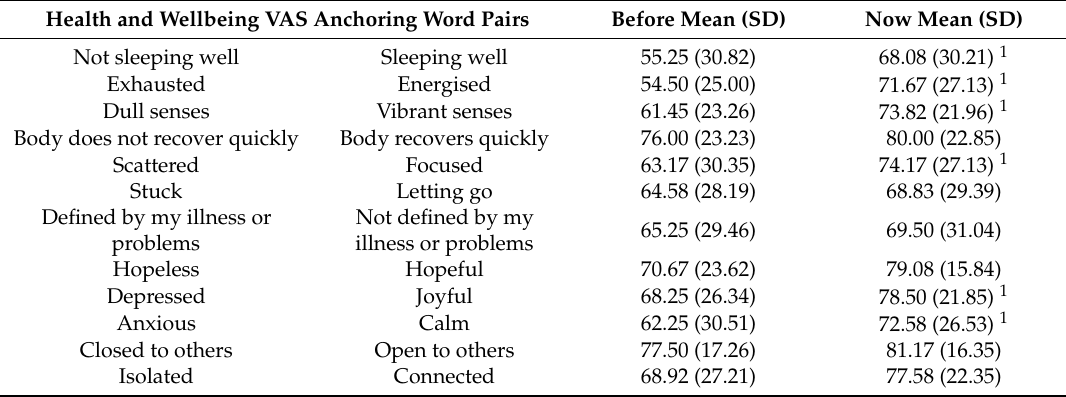
Table 1. Mean and standard deviation for health and wellbeing measured at T12 by the modified Self-Assessment of Change (mSAC) scale comprised of sixteen 100 mm visual analogue scales (VAS) anchored with salient word pairs ( n = 12 walkers).